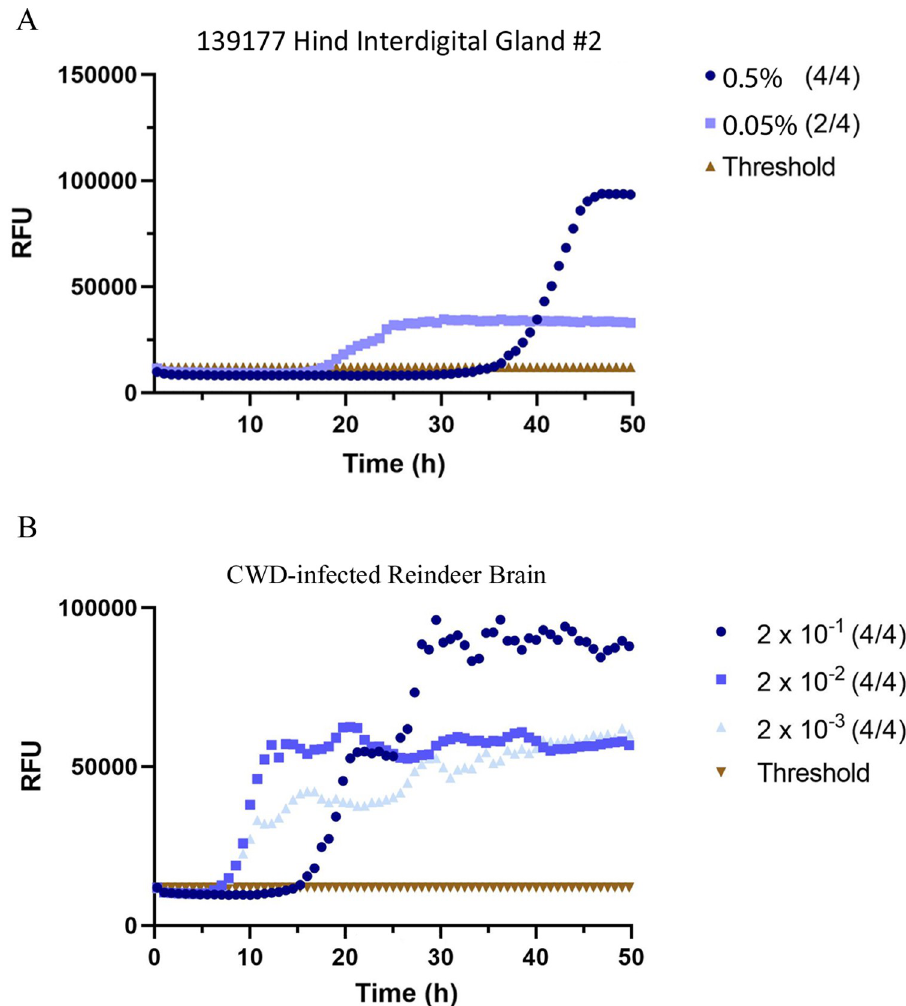
Fig 6. RT-QuIC detection of PrP CWD in blinded mule deer leg interdigital glands. (A) Representative example of single-round RT-QuIC detection of PrP CWD in one interdigital gland of a CWD-infected mule deer. (B) CWD- infected reindeer brain homogenate positive control. Samples were tested in quadruplicate with average relative fluorescence units (RFU) displayed. Gland homogenates were diluted to 0.5% and 0.05% (w/v) final concentrations.